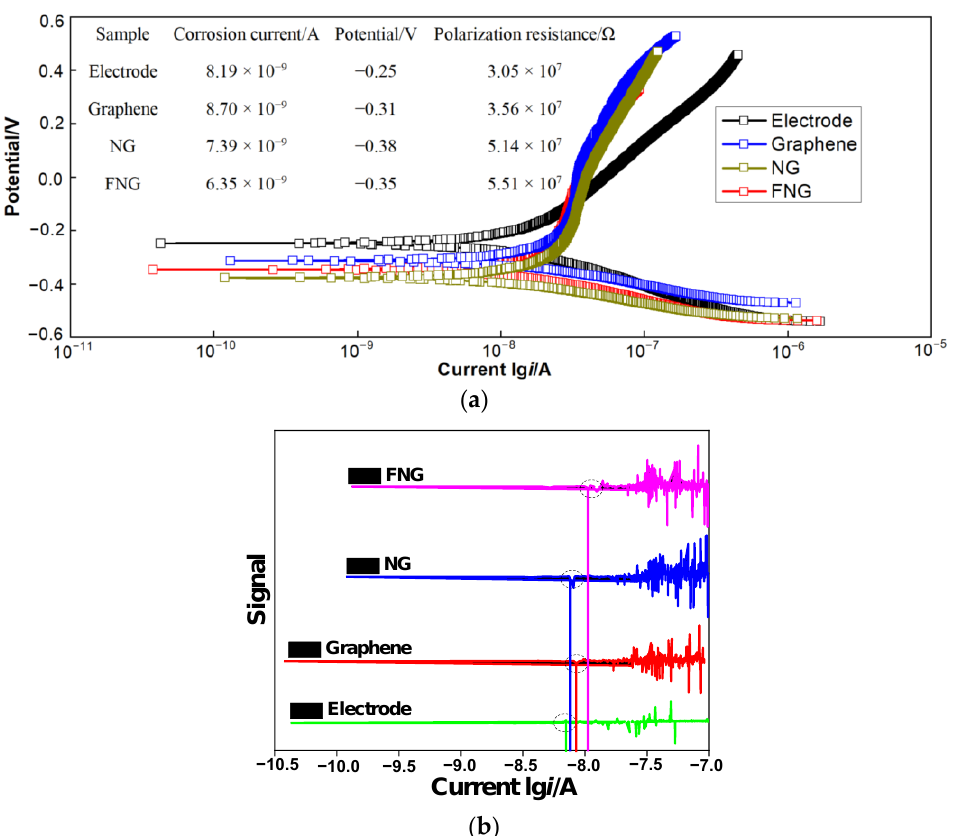
Figure 9. Dynamic polarization ( a ) and response of reactive oxygen curves ( b ) of electrode, graphene, NG, and FNG films. Table 1. Experimental parameters of EIS fitting.